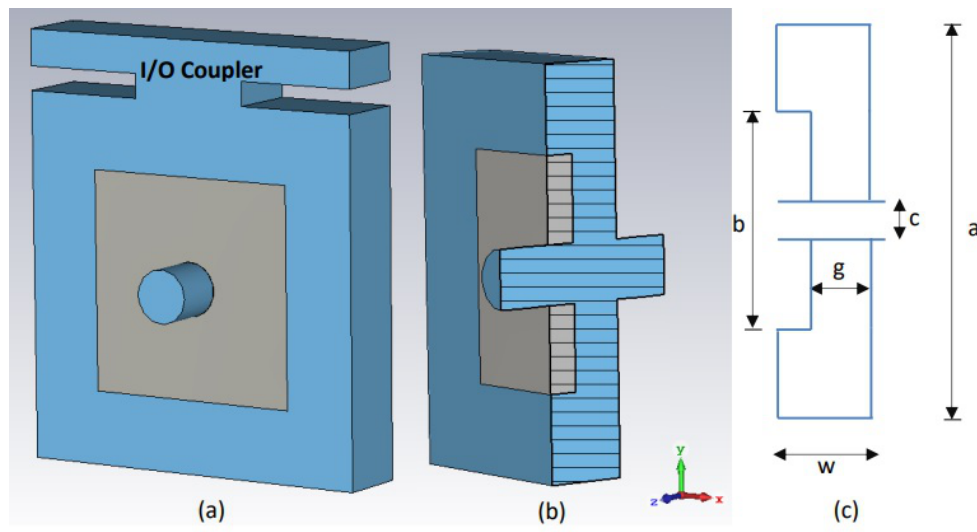
Figure 1. Perspective view of RRSC: ( a ) input/output cavity, ( b ) intermediate cavity, and ( c ) cross section of an intermediate cavity.